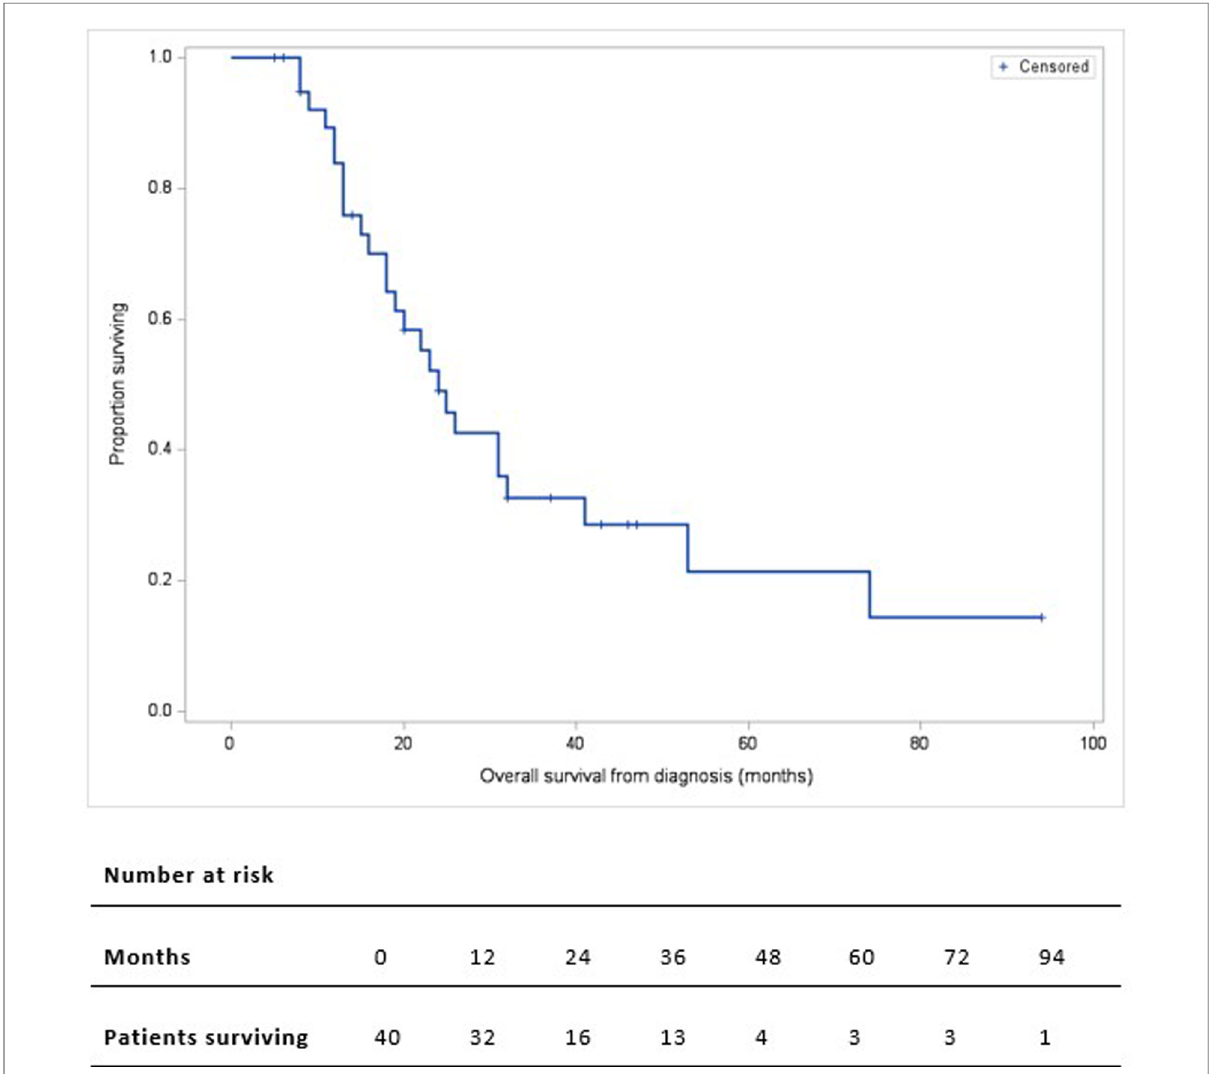
FIGURE 2 Kaplan-Meier overall survival curve of 40 patients who underwent pancreatectomy with PV/SMV resection for BR/LA PC. Overall survival is calculated from the time of